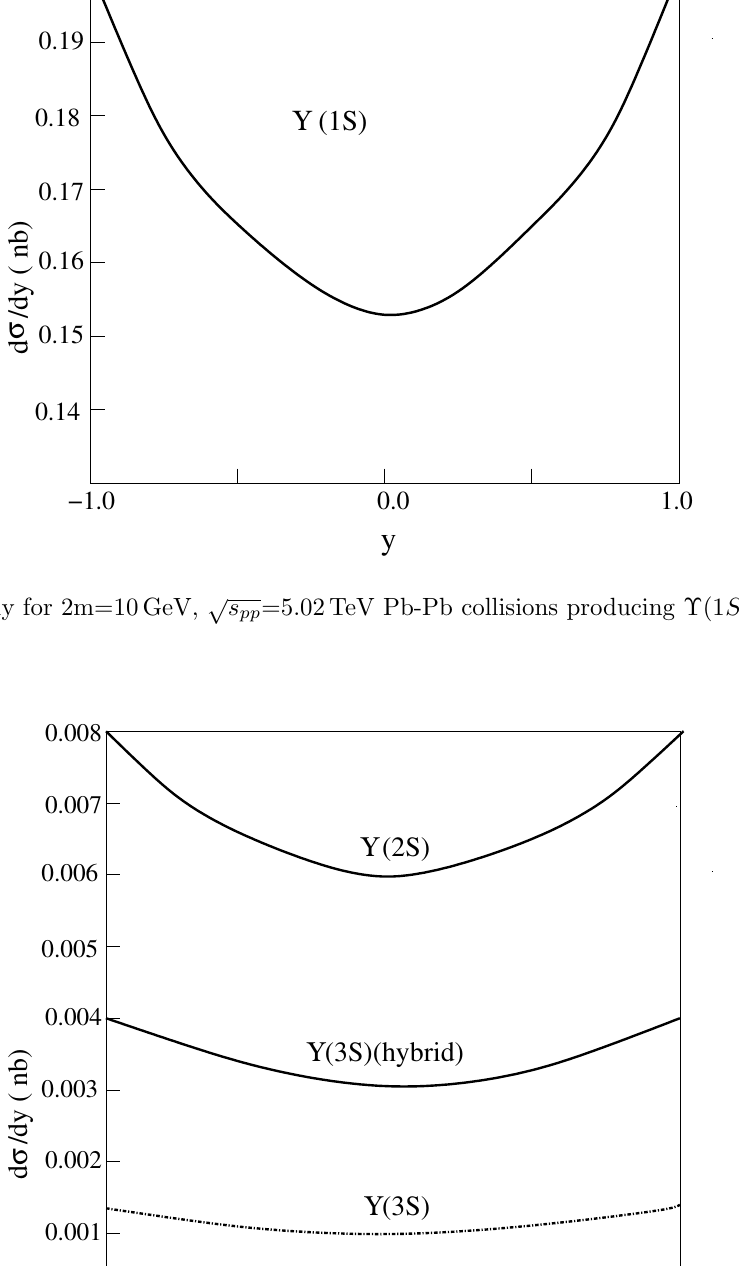
p Figure 4 . d (cid:27) /dy for 2m=10 GeV, s pp =5.02 TeV Pb-Pb collisions producing with (cid:21) = 0 (cid:7)(2 S ) and (cid:7)(3 S )(hybrid). For (cid:7)(3 S ) the dashed curve is for the standard b (cid:22) b model.